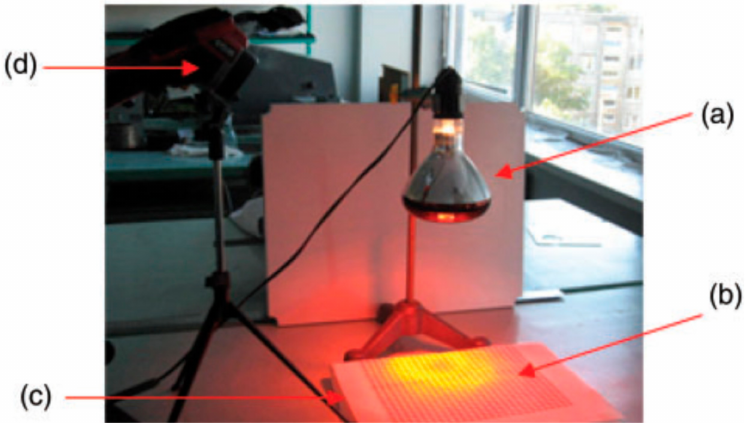
Figure 2. Stand for the analysis of fabric dynamic thermal behaviour: ( a ) infrared lamp; ( b ) 3D warp-knitted spacer PET fabric; ( c ) polystyrene foam plate; ( d ) thermal